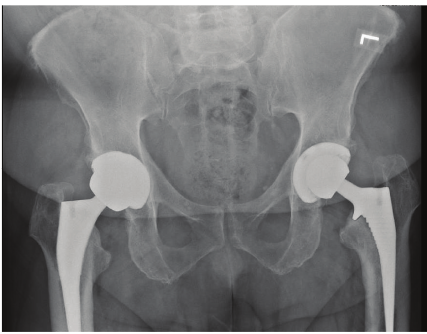
Figure 1: AP pelvis of the primary THA showing good alignment without